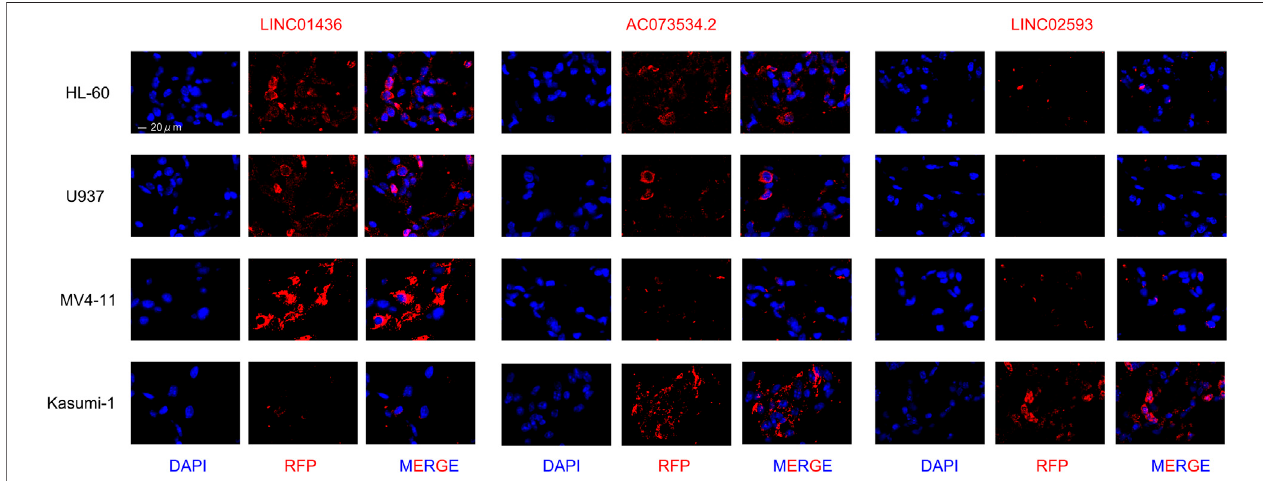
FIGURE 12 | FISH staining in LINC01436, AC073534.2, and LINC02593 in AML cell lines HL-60, U937, MV4-11, and Kasumi-1 (original magni fi cation ×630).